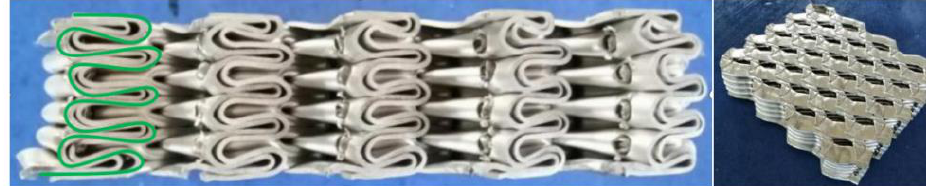
Figure 16. The final configuration of axial